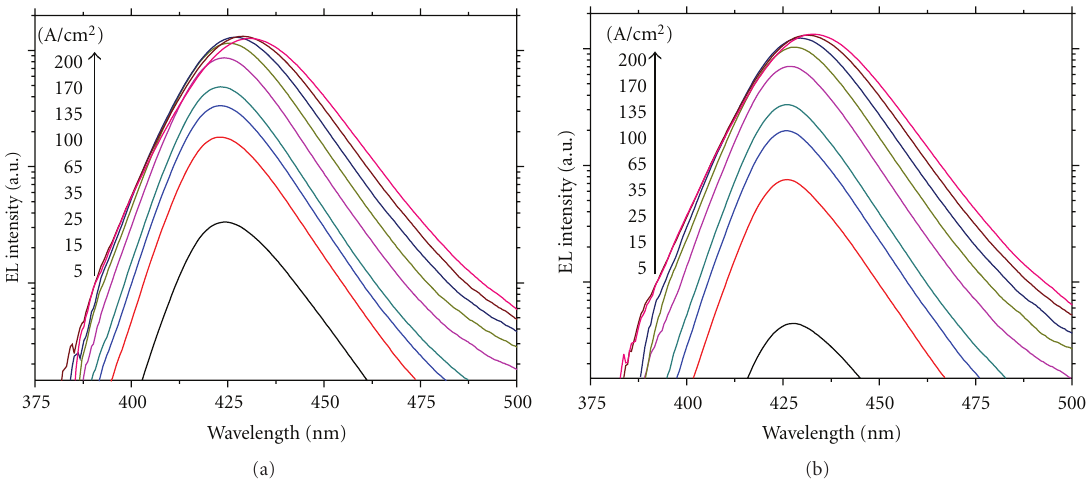
Figure 3: EL spectra of (a) sample A and (b) sample B at various forward current densities.